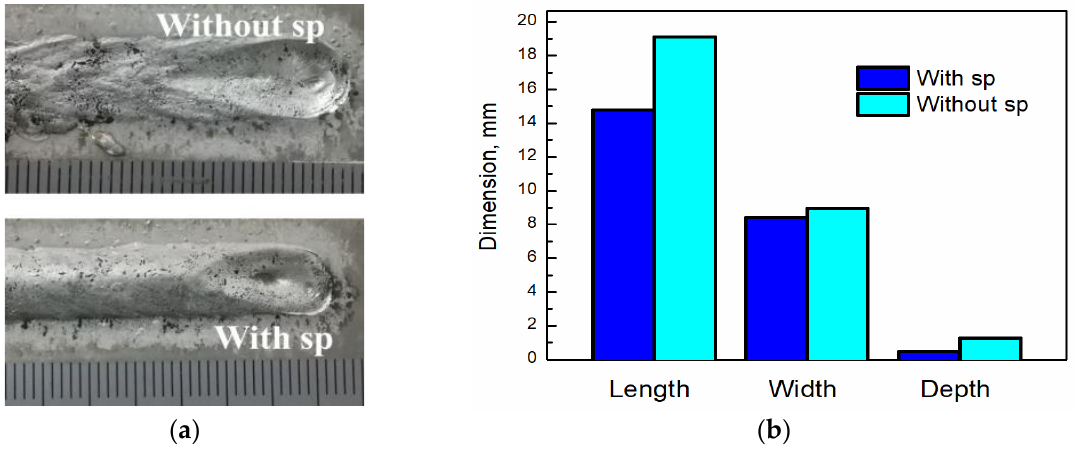
Figure 13. Comparison of crater with and without supporting plates. ( a ) profile; ( b ) dimension.